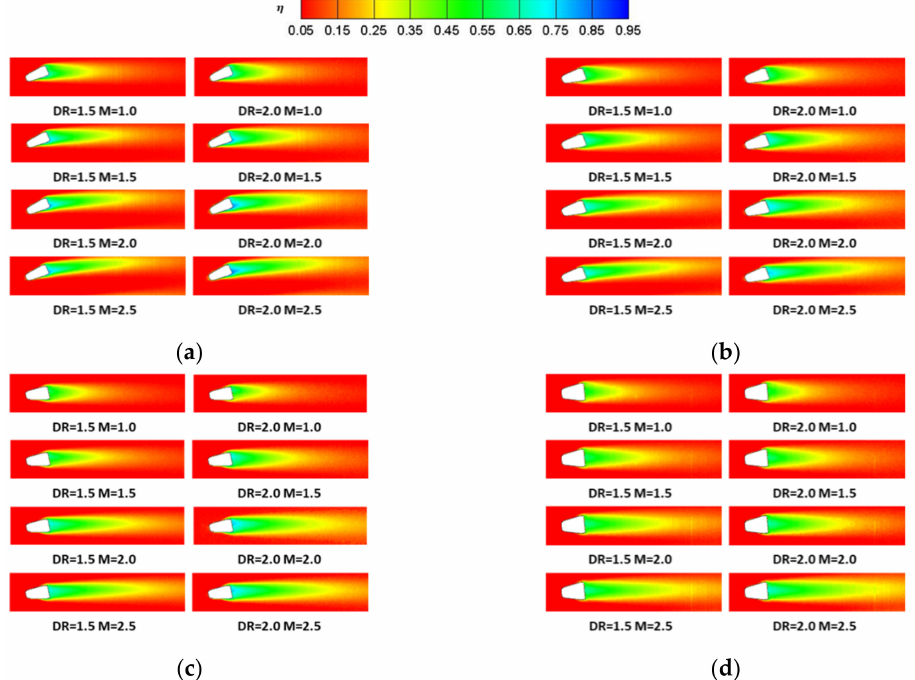
Figure 14. Distribution of optimized asymmetric laidback fan shaped hole ( a ) optimized hole at M = 1.0 (5.46-8.33-24.56); ( b ) optimized hole at M = 1.5 (3.49-14.7-20.91); ( c ) optimized hole at M = 2.0 (3.94-15-11.82); ( d ) optimized hole at M = 2.5